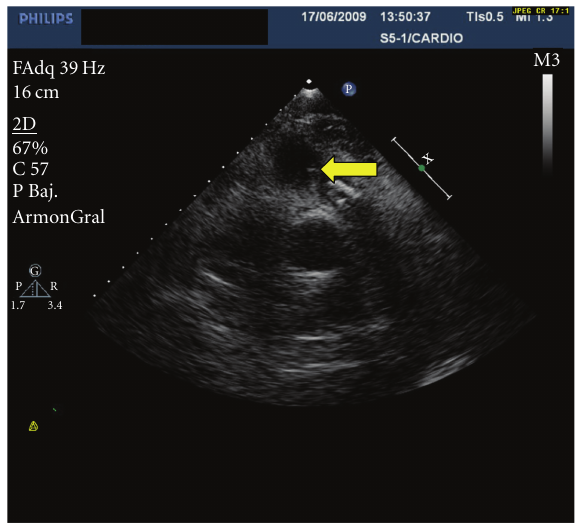
Figure 1: Transthoracic echocardiography parasternal section showing a thickened and calcified pulmonary valve with adhered vegetations.